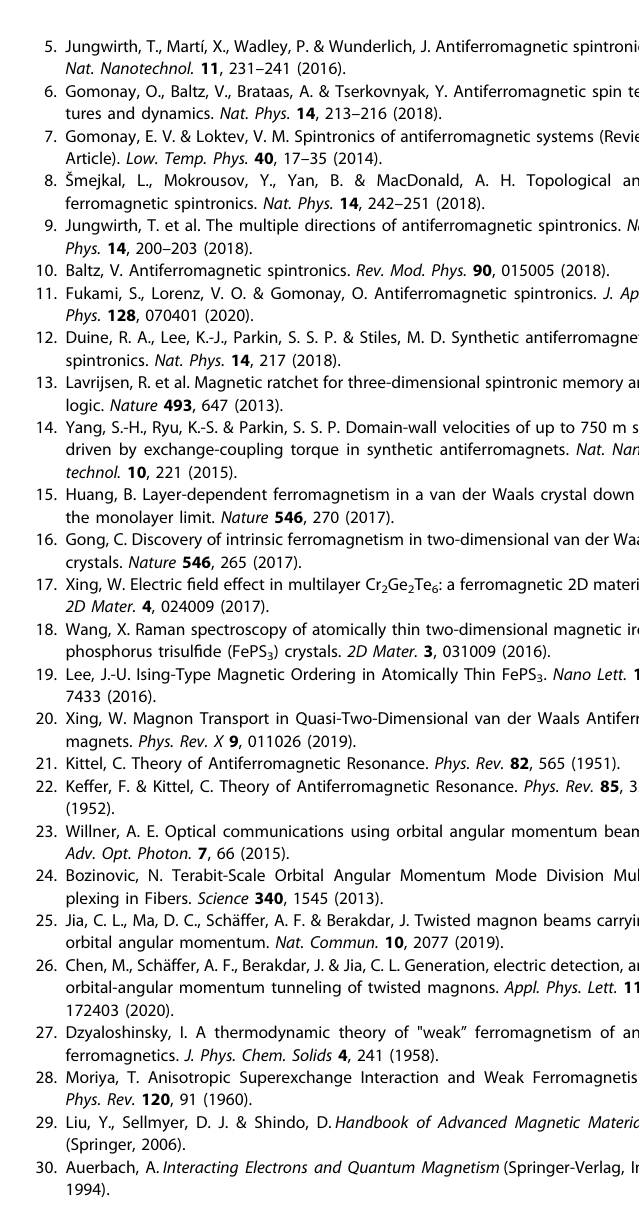
ℓ = ±1 and ( c ) the same combination of beams